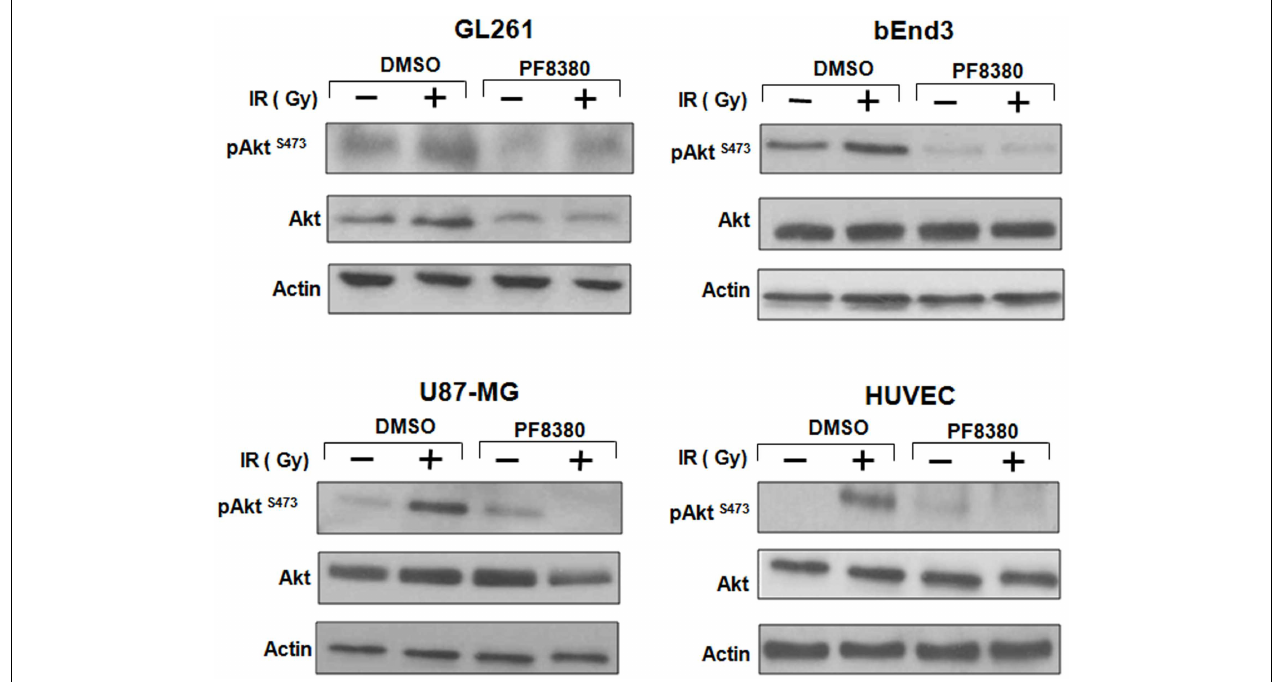
Cells were lysed 15min after irradiation and cellular proteins were immunoblotted using antibodies against pAkt Ser473/Thr308 , total Akt, to analyze levels of expression of these proteins. Actin was used to evaluate the protein loading in each